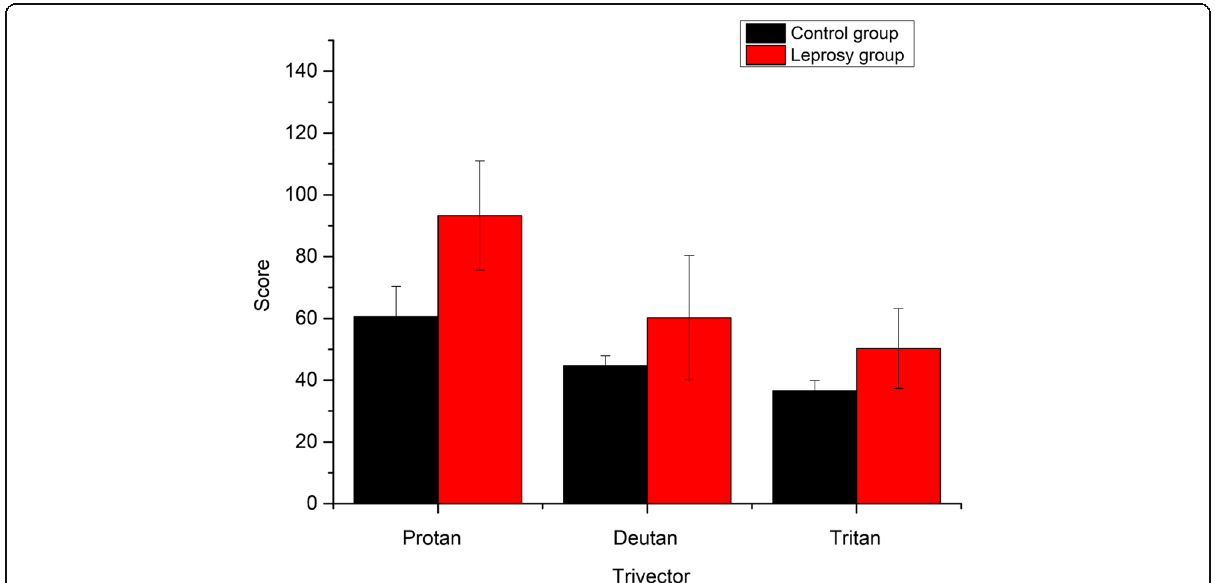
Fig. 3 Mean results of the Trivector protocol ( U'V' × 10 3 ) for subjects with normal vision and